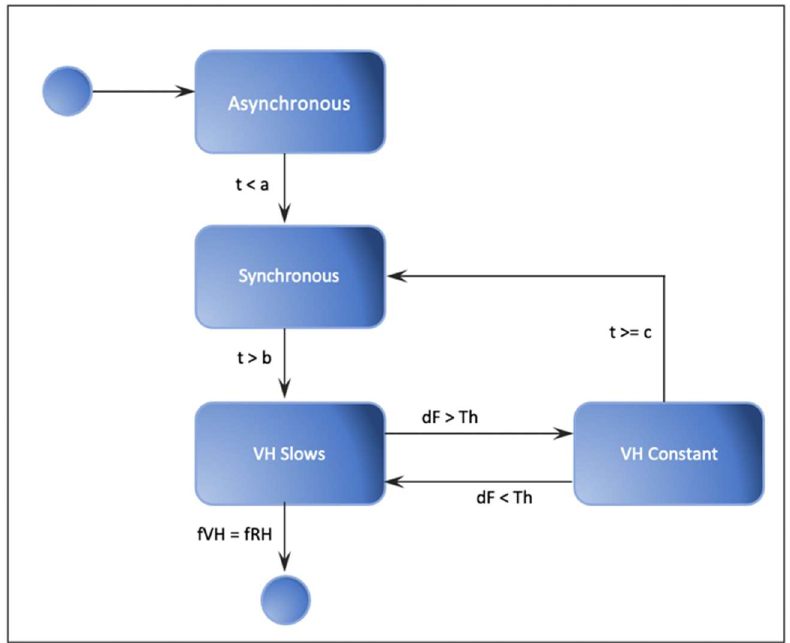
Figure 7. Active entrainment using a finite state machine. Initially, user and VH are breathing at different rates (Asynchronous). After time a, the VH changes its breathing frequency to match the participants (Synchronous). After time b, the VH slows down its breathing frequency. Once the threshold difference Th between the two breathing frequencies is reached, the VH breaths at a constant frequency. Depending on whether the threshold is reached, the VH either re-synchronises with the user or remains at its current breathing frequency.